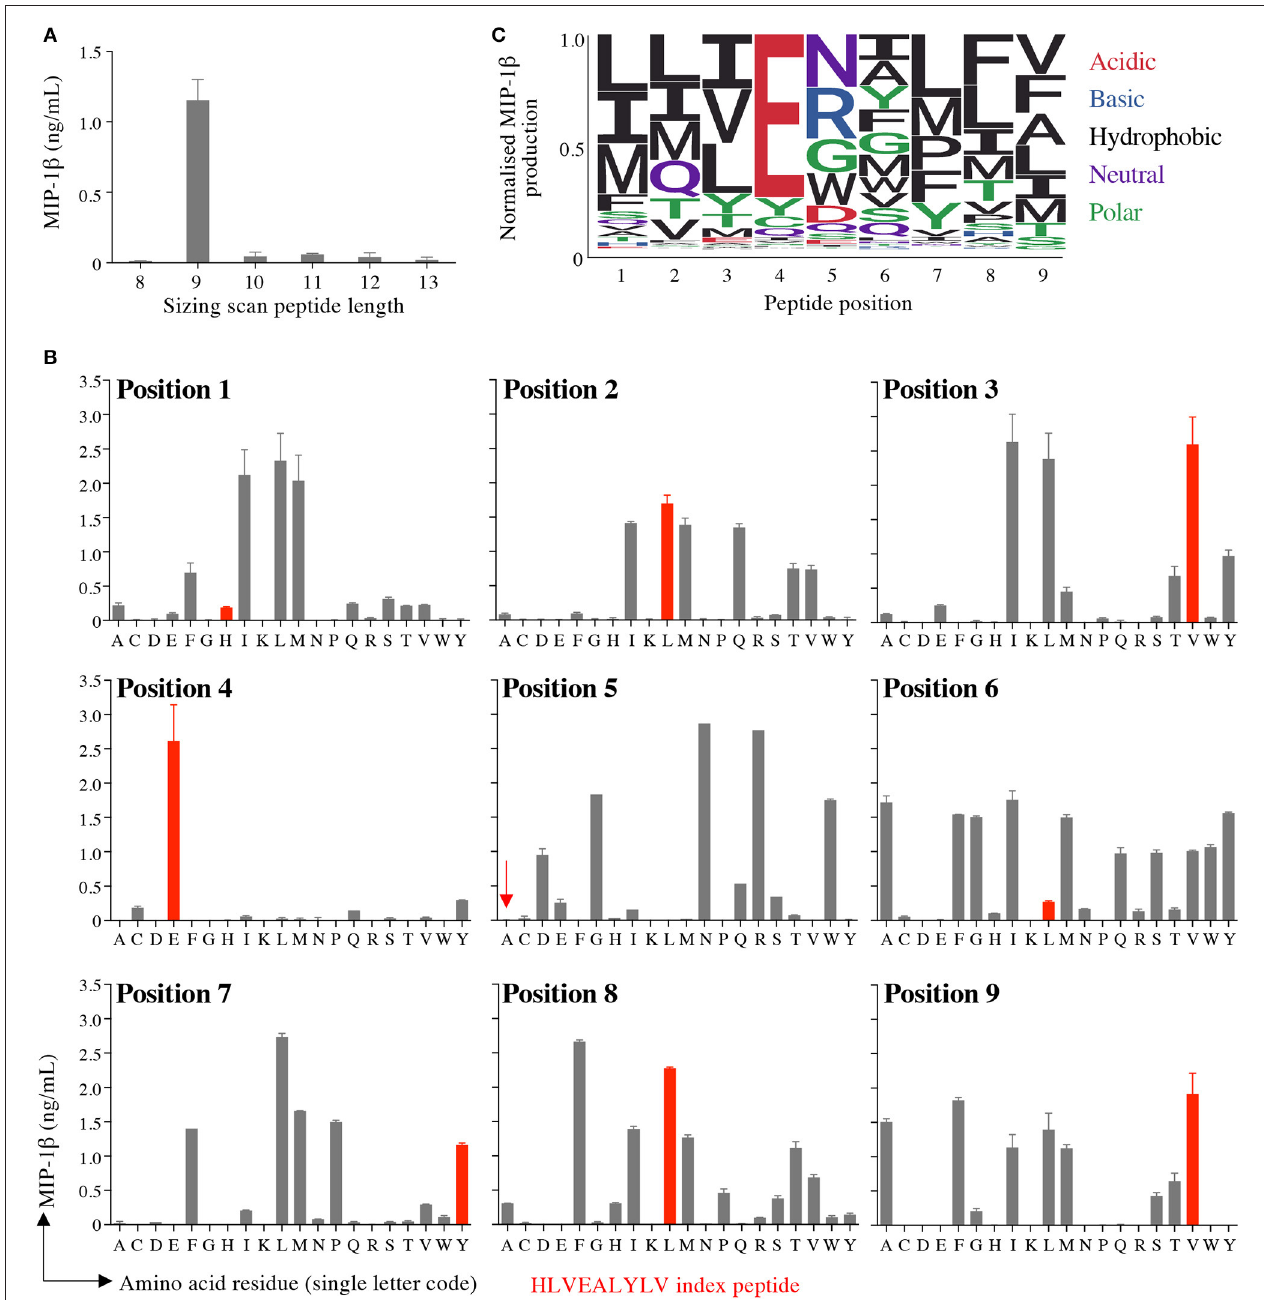
FIGURE 3 | Sizing scan and nonamer combinatorial peptide library screening of InsB4. (A) Sizing scan of the InsB4 clone; overnight activation in duplicate followed by MIP-1 β ELISA. Error bars depict SEM. (B) Overnight activation in duplicate with MIP-1 β ELISA. Index peptide residues shown in red. Error bars depict SEM. (C) Logo plot of normalised MIP-1 β expression from data presented in panel